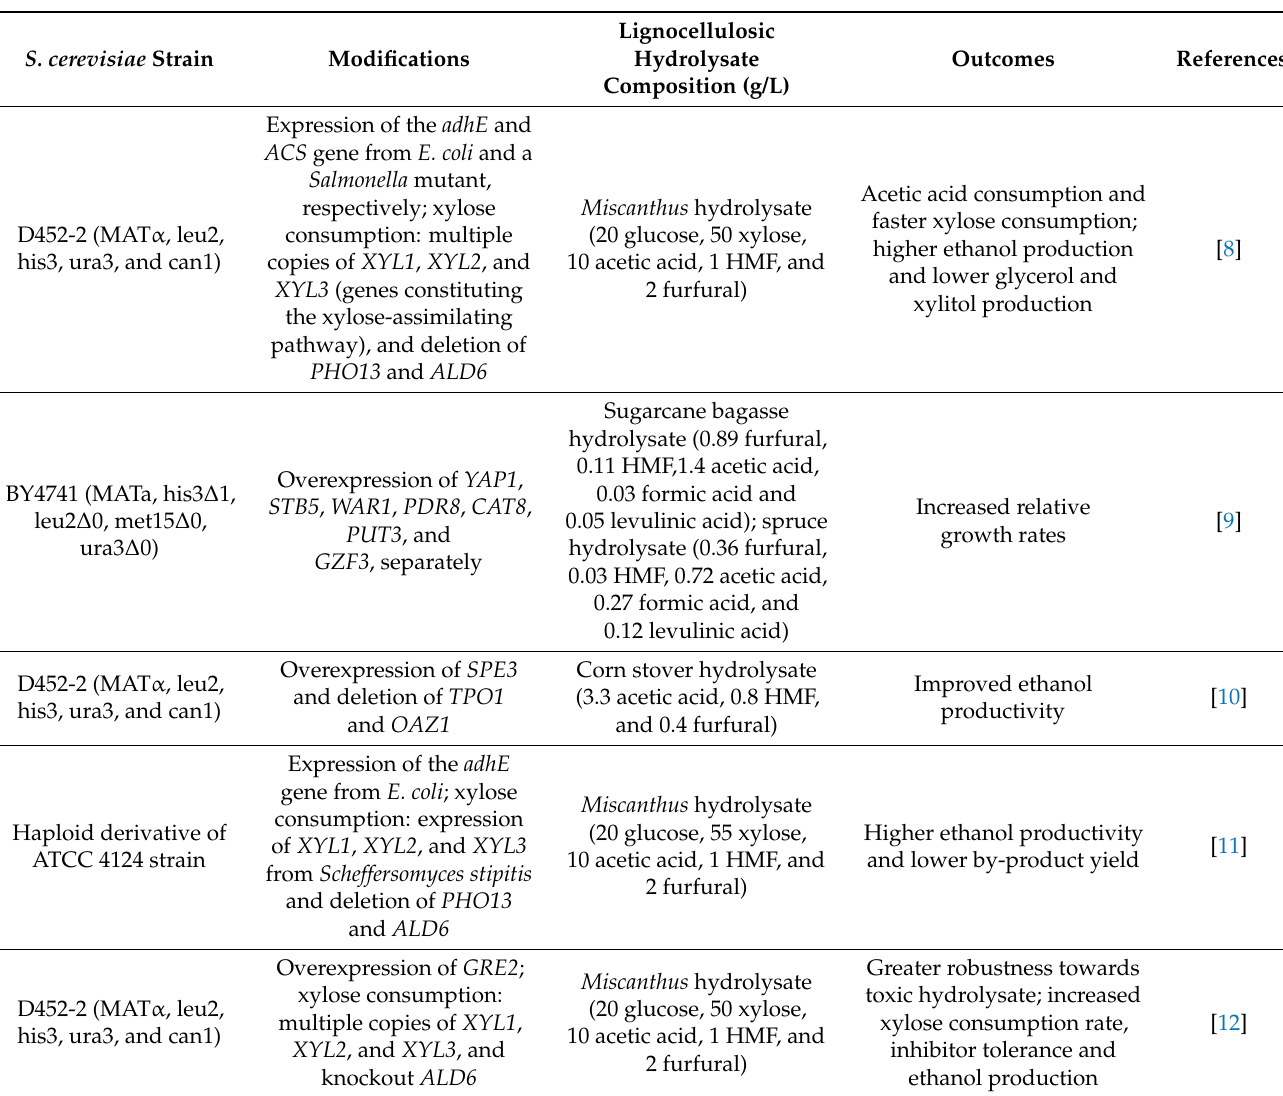
Table 1. Recent studies on the application of engineered Saccharomyces cerevisiae strains towards improved tolerance to inhibitors in lignocellulosic hydrolysates. Adapted from [6], with permission of Springer Nature,